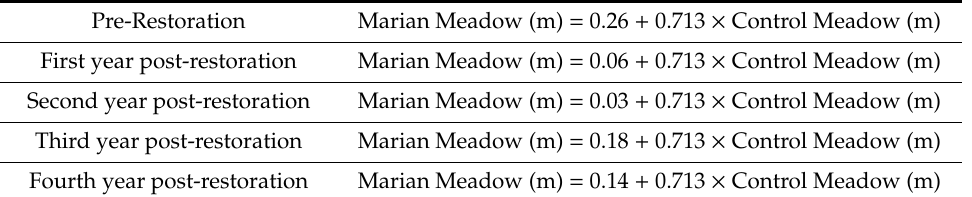
Table 5. Regression equations for depth to groundwater between Marian Meadow and Control Meadow for pre-restoration (2014–2015 WY) and each year after restoration (2016–2019 WY).